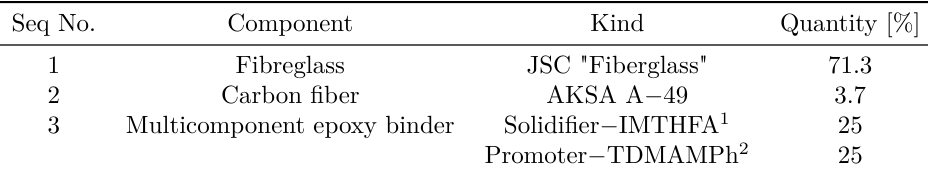
Figure 1. Experimental samples of FRPR; CF location.